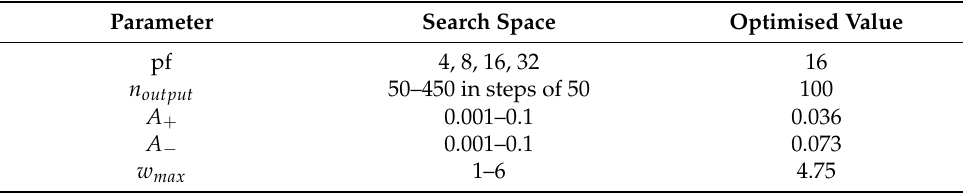
Table 2. Final optimised parameter values for the